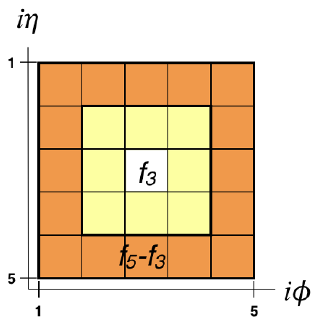
Figure 2. Central 5 (cid:2) 5 part of the 28 (cid:2) 28 i(cid:17) (cid:0) i(cid:30) image. The fraction of total energy (in 28 (cid:2) 28 i(cid:17) (cid:0) i(cid:30) region) deposited in this part is f 5 . The central 3 (cid:2) 3 part has energy fraction f 3 (yellow and white) and the rest has energy fraction f 5 (cid:0) f 3 (orange). f 3 contains the central highest energy tower (shown in